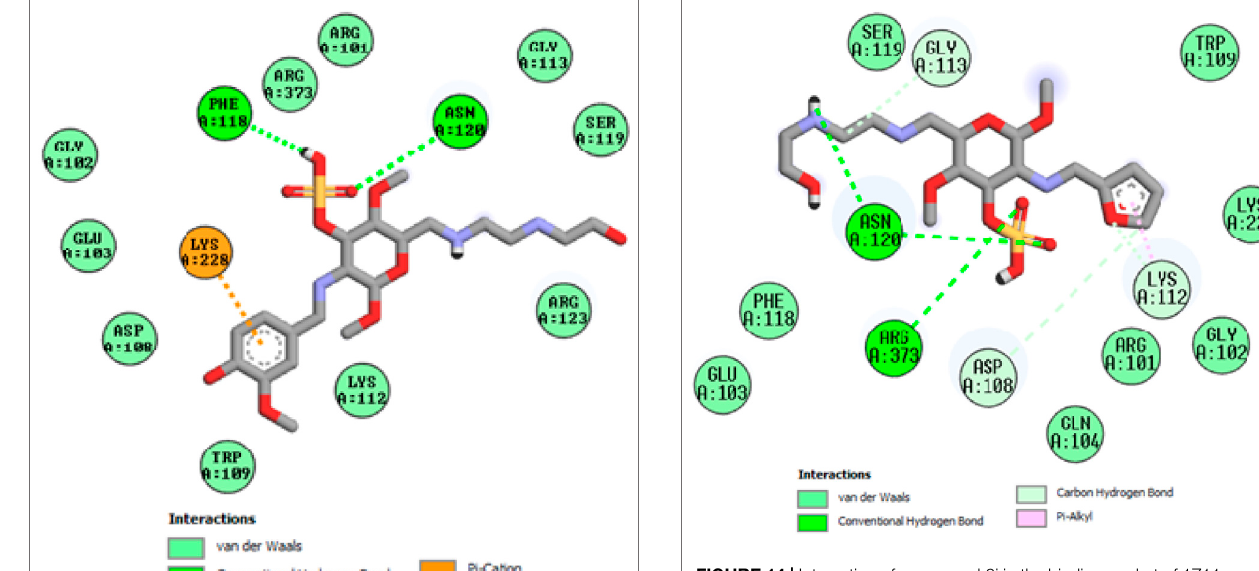
FIGURE 14 | Interaction of compound 2j in the binding pocket of 1Z11